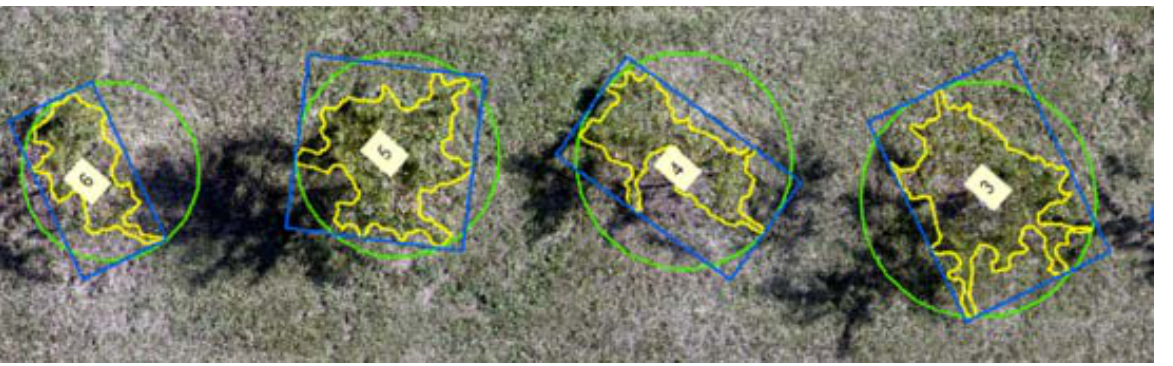
Figure 3. Individual tree boundary (polygon, bounding box, and circle) used to extract the tree height and canopy crown